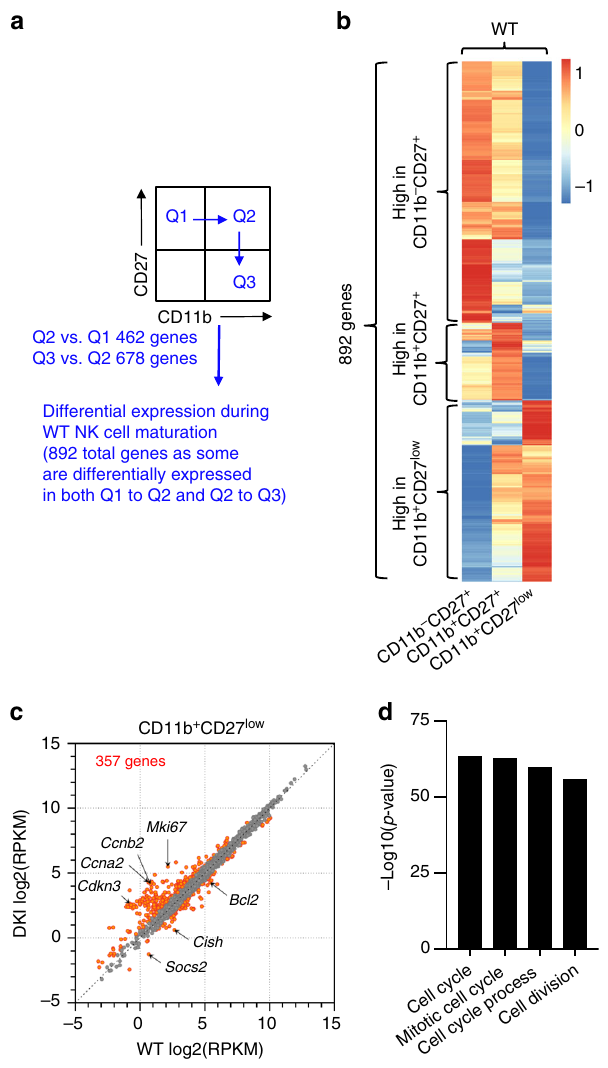
Fig. 2 Altered gene expression in Stat5 double knockin (DKI) NK